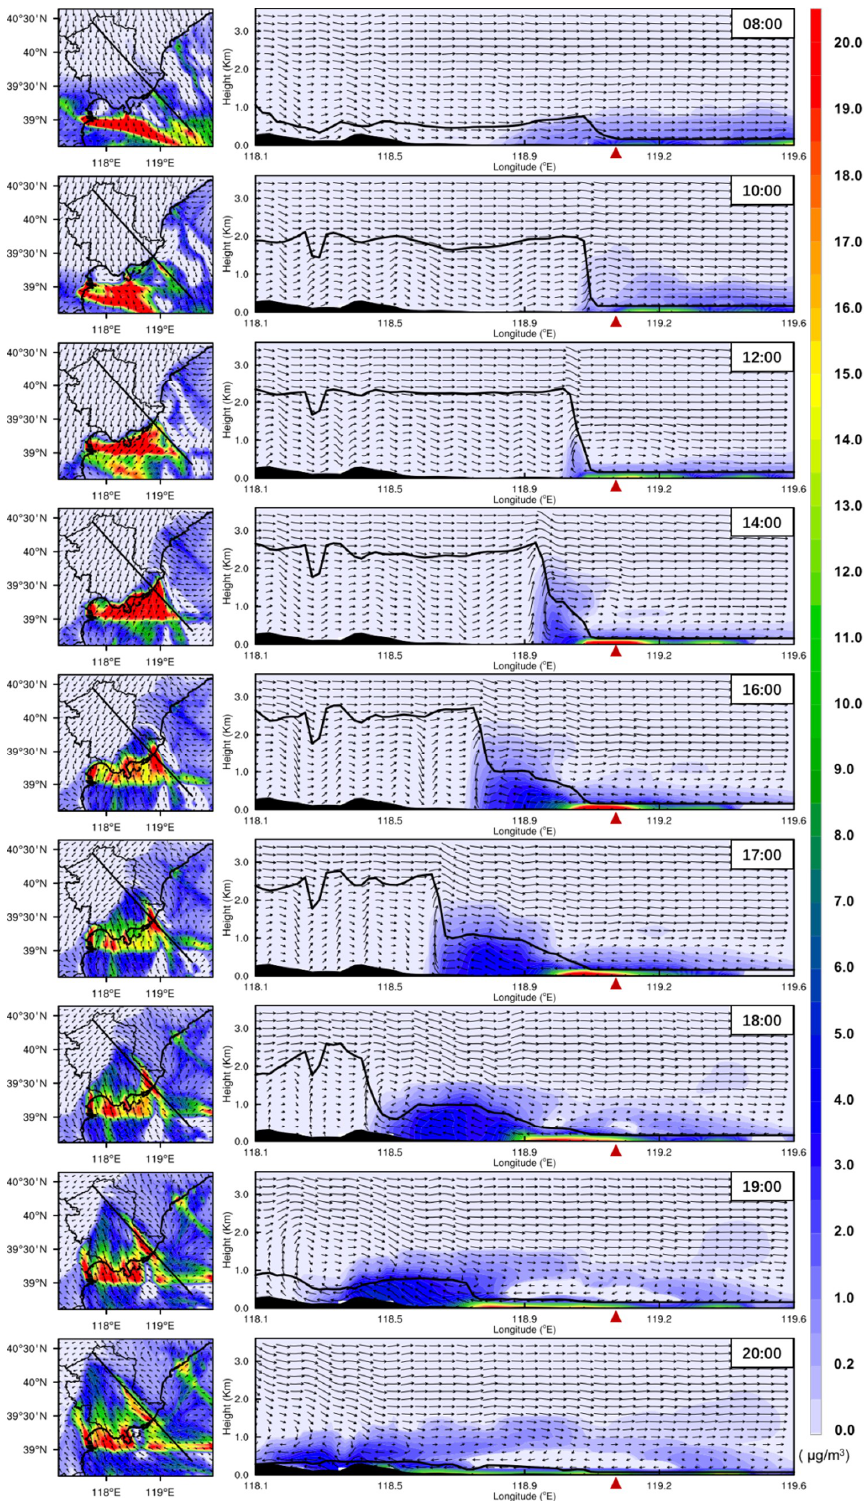
Figure 5. The horizontal (left column) and vertical (right column) axes represent the evolution of ship-contributed NO 2 overlaid by wind vectors. The black lines in the left column indicate the locations of the vertical cross sections shown in the right column. The black curves in the right column show the top of the atmospheric boundary layer (obtained from the model output for each grid along the vertical cross section). The red triangles in the right column indicate the location of the sea–land boundary.